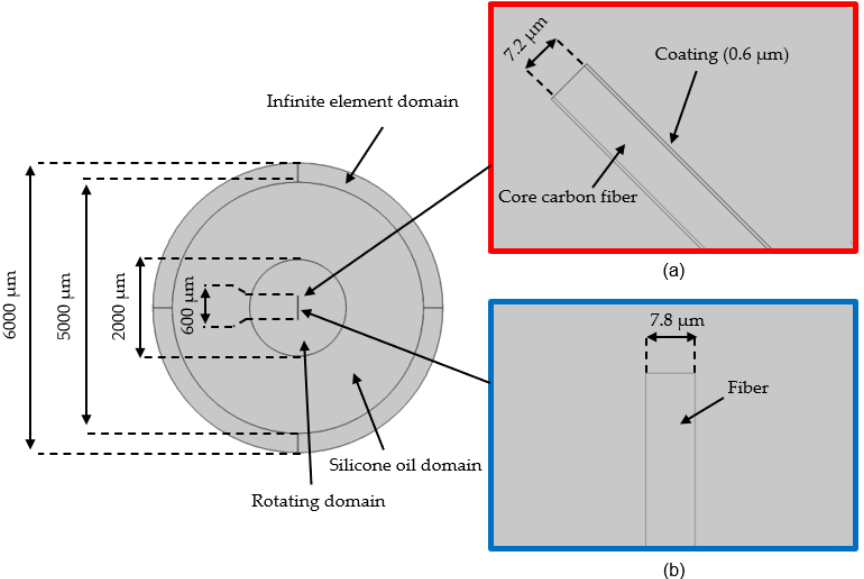
Figure 5. The geometry of the simulation model with coating thickness 0.6 µm and fiber length 600 µm: ( a ) stage 1—magnetostatic simulation; ( b ) stage 2—dynamic FSI simulation.